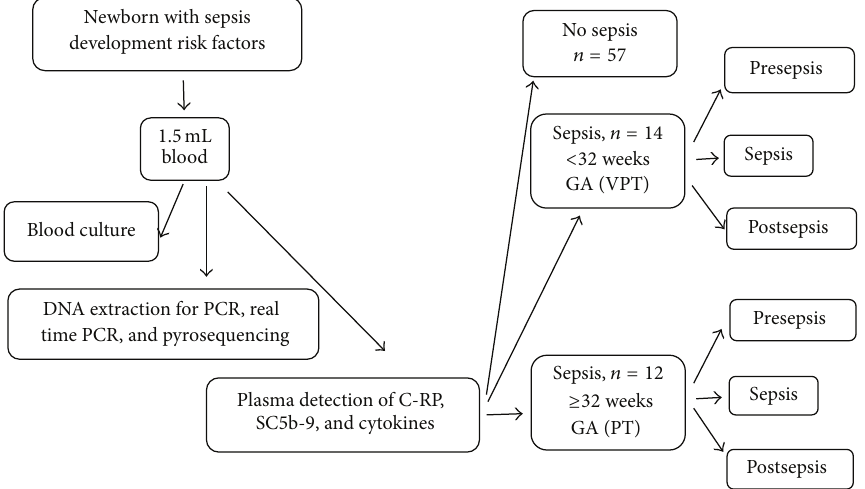
Figure 1: Flow diagram for patient